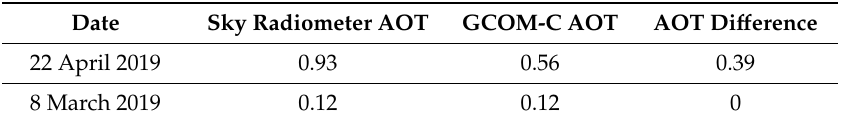
Table 8. The sky radiometer and GCOM-C AOT on some selected days at the Chiba